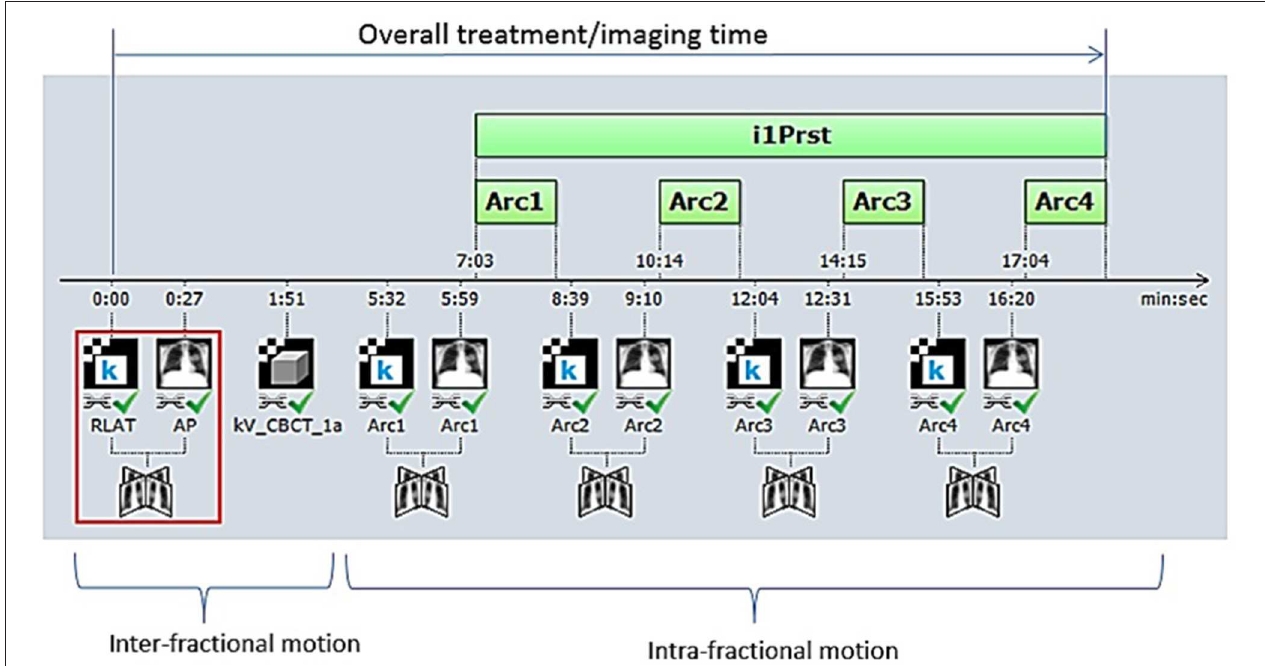
FIGURE 1 | Our image-guided work flow during the treatment of stereotactic body radiation therapy for prostate cancer. Initially, patient positioning is accomplished by orthogonal image pair or stereoscopic X-ray imaging with ExacTrac ® and cone-beam computed tomography (CBCT) before treatment beam-on. Repeat orthogonal image pair or stereoscopic X-ray imaging is obtained prior to each beam delivery (each of three remaining half-arcs) to account for intra-fractional motion. Each half-arc is delivered over ∼ 2–3min.